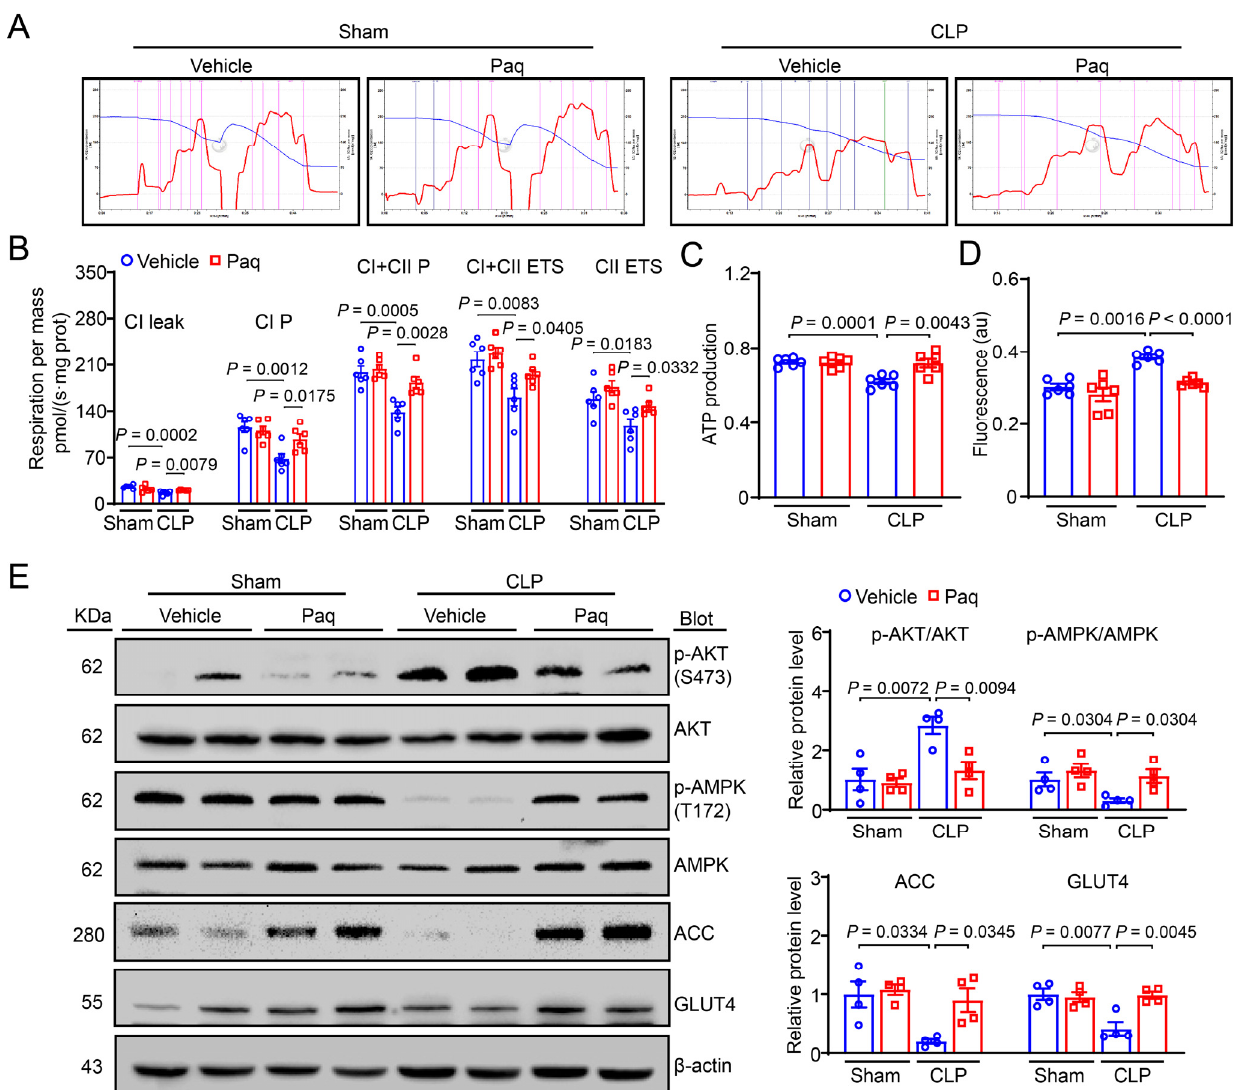
Figure 7. Administration of S100A9 inhibitor ameliorates liver mitochondrial dysfunction through increasing AMPK-mediated glucose and lipid metabolism. ( A ) Representative images of O 2 concen- tration change (blue line) and O 2 flux per mass (red line) in groups. ( B ) Summarized data for the oxygen consumption capacity measured by high-resolution respirometry in CI leak, CI P, CI + CII P, CI + CII ETS, CII ETS ( n = 6). ( C ) ATP production and ( D ) fluorescence (represent mitochondrial membrane potential) ( n = 6). ( E ) Immunoblotting analysis of p-AKT, AKT, p-AMPK, AMPK, ACC, GLUT4 (left) and quantification of the relative protein levels (right, n = 4). Data are shown as mean ± SEM, and n represents the number of mice in each group.